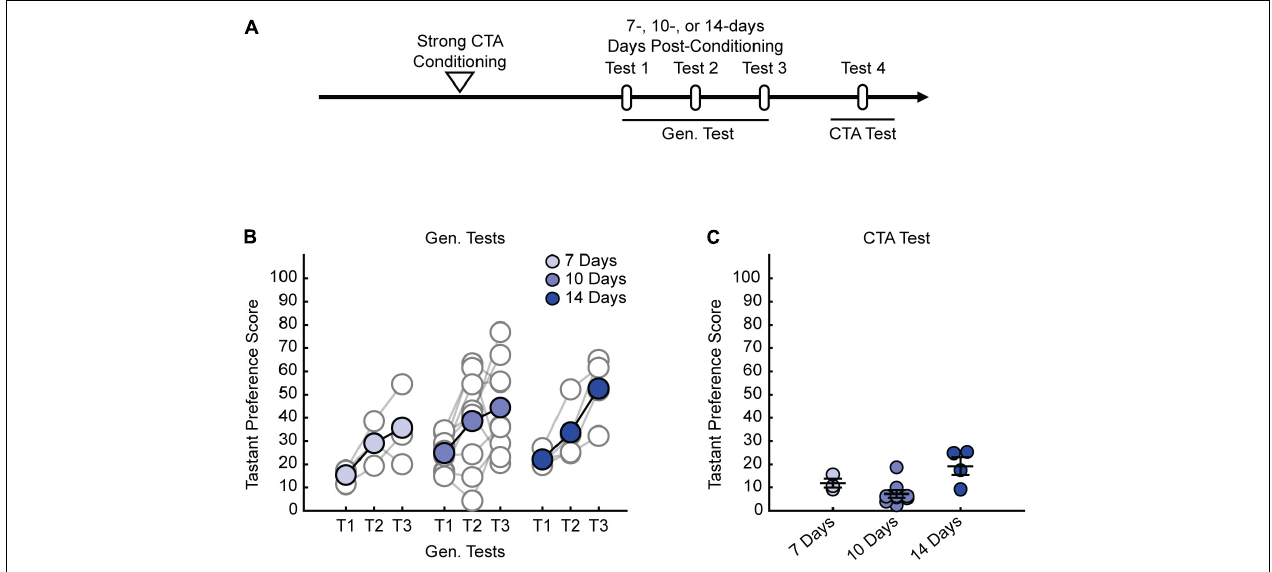
FIGURE 2 | Strong CTA-induced generalized aversion can be observed up to 2-weeks post-conditioning. (A) Two-bottle CTA learning paradigm for testing the persistence of the generalized aversion at 7-, 10-, and 14-days post-conditioning. (B) Repeated Gen. test; preference score for NaCl tested 7-, 10-, and 14-days experimental conditions. Each test is separated by a 24-h interval. (C) CTA test; preference score for saccharin of long-duration experimental